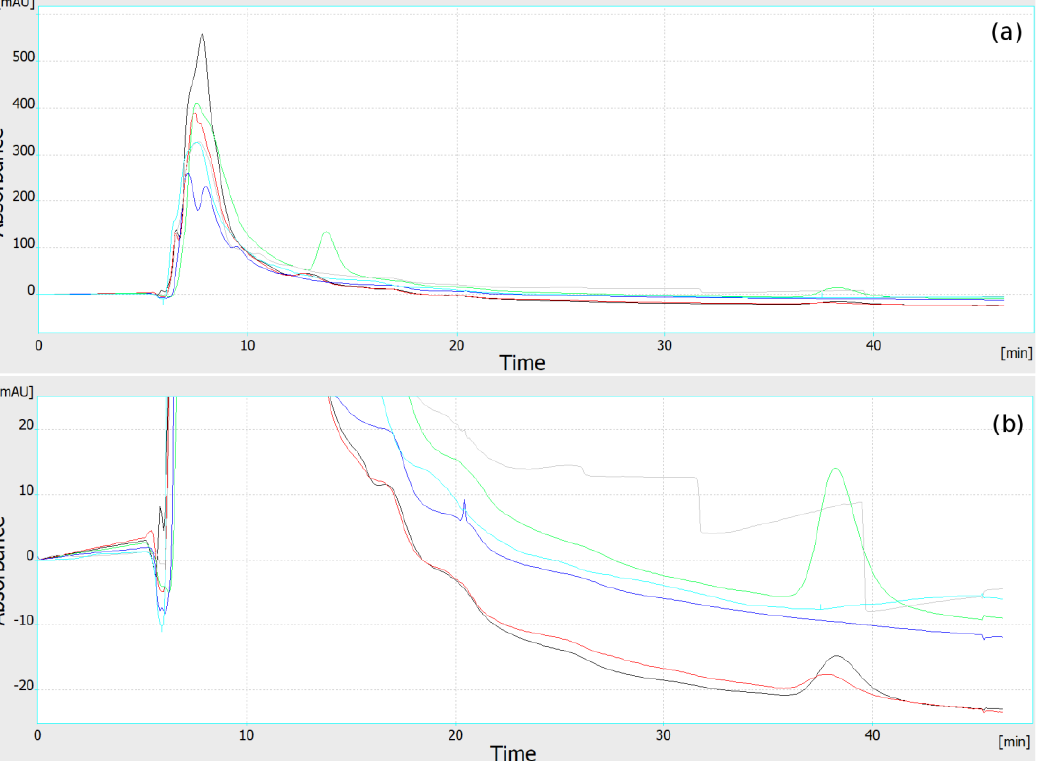
Figure 1. Preconditioning (equilibration) of separation system. Six chromatograms (each of different color) from six independent detectors obtained simultaneously, during procedure of adsorbent layer washing: ( a ) full view, ( b ) scaled down fragment. All detectors respond at the same time to the front of the mobile phase flow. Baselines do not reach plateau for over 45 min of equilibration. Mobile phase flow 0.25 mL/min.